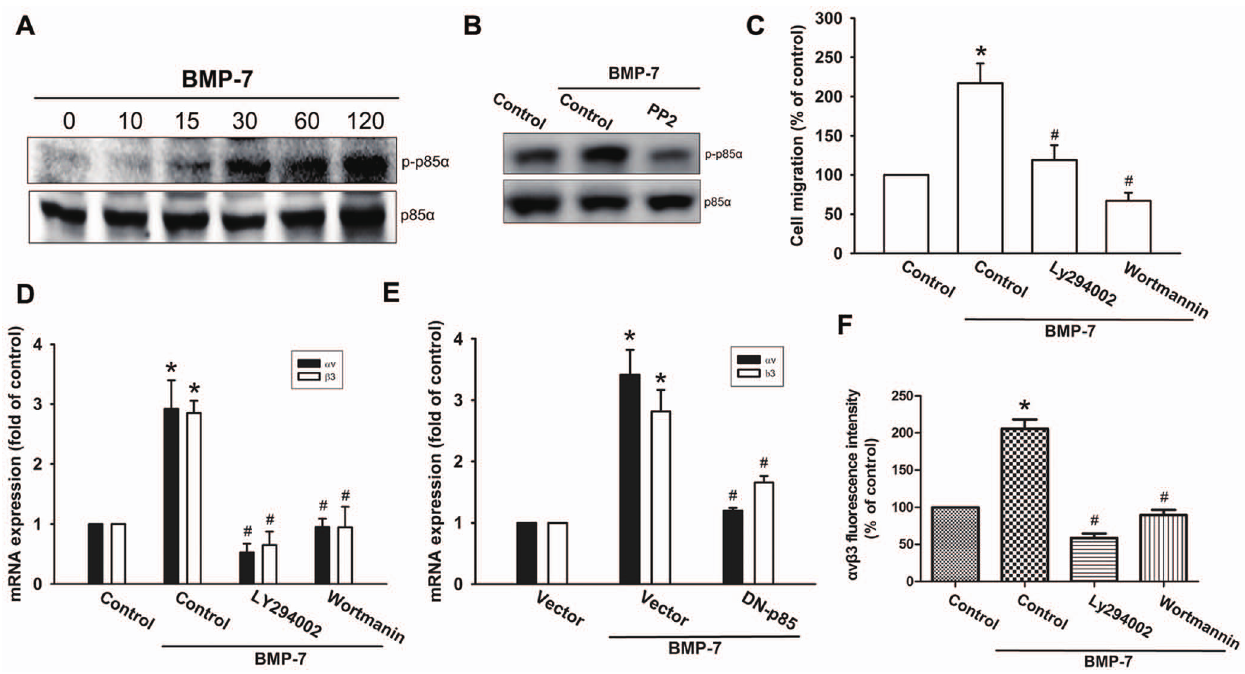
Figure 3. PI3K (p85 a ) is involved in BMP-7-induced migration and integrin a v b 3 expression. (A–B) JJ012 cells were incubated with BMP-7 for indicated time intervals or pretreated with PP2 for 30 min followed by treatment with BMP-7 for 2 h. The levels of p-p85 a and p85 a were measured by Western blot. Data are representative of at least three independent experiments. (C) Cells were pretreated with Ly294002 (10 m M) or wortmannin (10 m M) followed by stimulation with BMP-7 for 24 h, and in vitro migration was measured by Transwell (n=4). (D–F) Cells were pretreated with PI3K inhibitor Ly294002 (10 m M) or wortmannin (10 m M) for 30 min or co-transfected with p85 mutant for 24 h followed by incubation with BMP-7 for 24 h. The expression of integrin a v b 3 was measured by q-PCR (n=4) and flow cytometry (n=5). Results are expressed as the mean 6 SEM. * p , 0.05, compared to basal expression levels. # p , 0.05, compared to expression levels in the BMP-7-treated group.